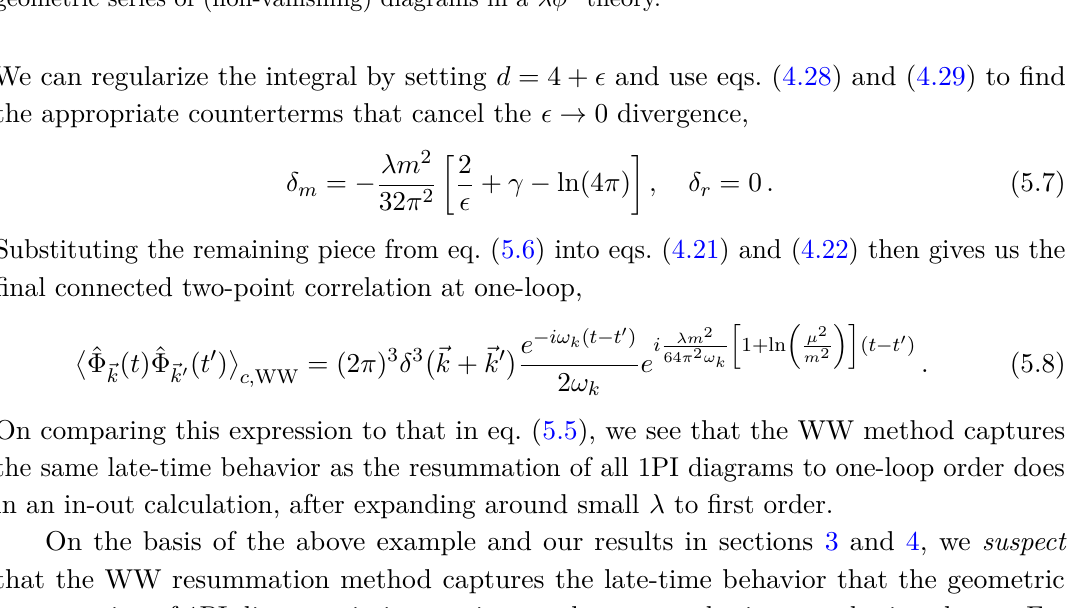
Figure 5 . (Top) The geometric series of O ( λ 2 ) 1PI diagrams that we expect is being resummed by the WW method when calculating the two-point correlation in a λφ 3 theory. (Bottom) A similar geometric series of (non-vanishing) diagrams in a λφ 4